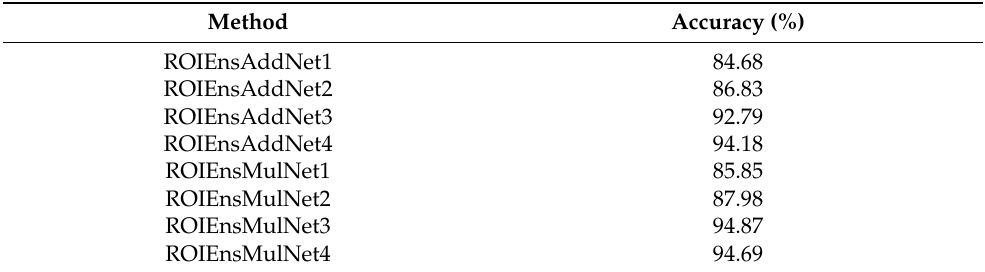
Table 4. Ensemble results (CS) of the ROI-based model.